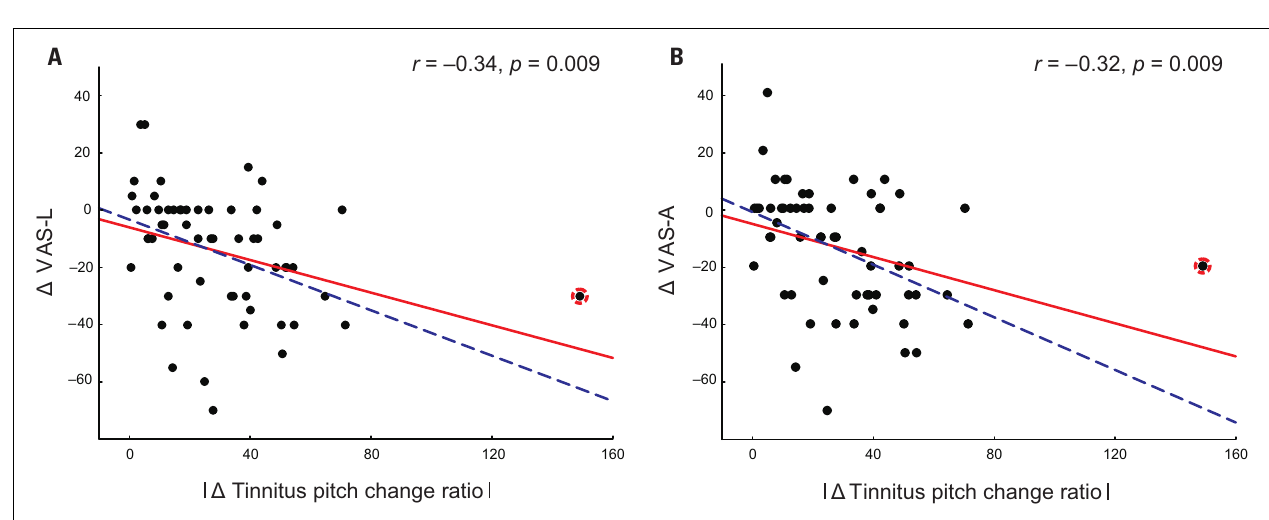
FIGURE 2 | Changes inVAS-L (A) andVAS-A (B) as a function of the modulus tinnitus pitch change ratio with all patients included ( n = 59, solid red line) or with the outlier (marked by the red circle) excluded from the analysis ( n = 58, dashed blue line).